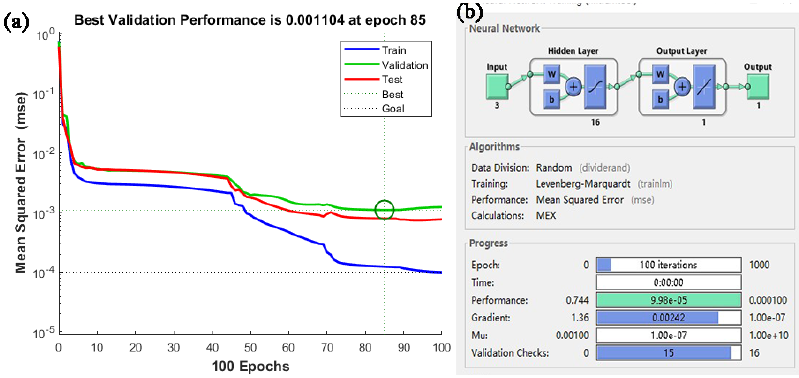
Figure 5. ( a ) Optimal ANN model training curve ( b ) and optimal ANN model structure and training parameters.